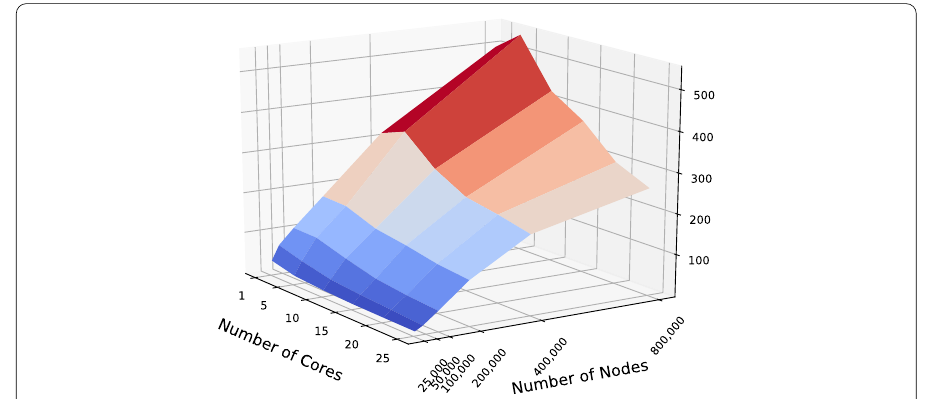
Fig. 7 Comparison with Brandes’ algorithm. Algorithmic speedup analysis- AS E / B p =[ 1,5,10,15,20,25